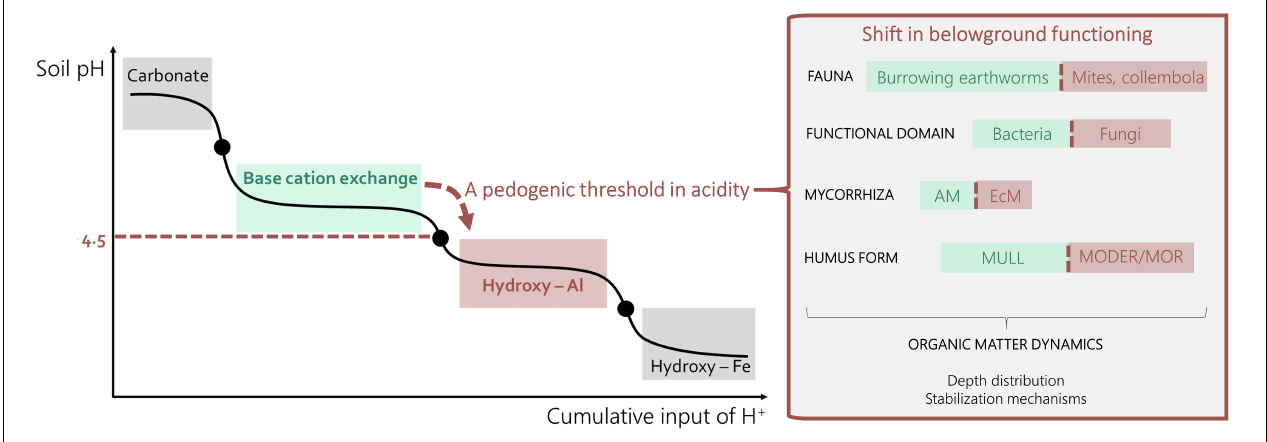
FIGURE 1 | Left: Soil pH-H 2 O is buffered by several subsequent mechanisms. These soil process domains are interchanged by pedogenic thresholds ( BOX1 ). Right: A shift from the exchange domain to the aluminum domain cascades through belowground functioning and ultimately affects SOC